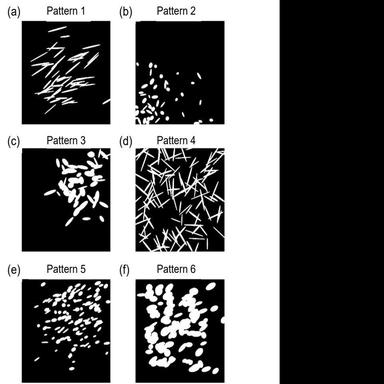
a)-(f) different 2-D spatial patterns for fibrous element structures within the material basis. The reinforcing elements (white regions) are distinguished from the base (black regions).